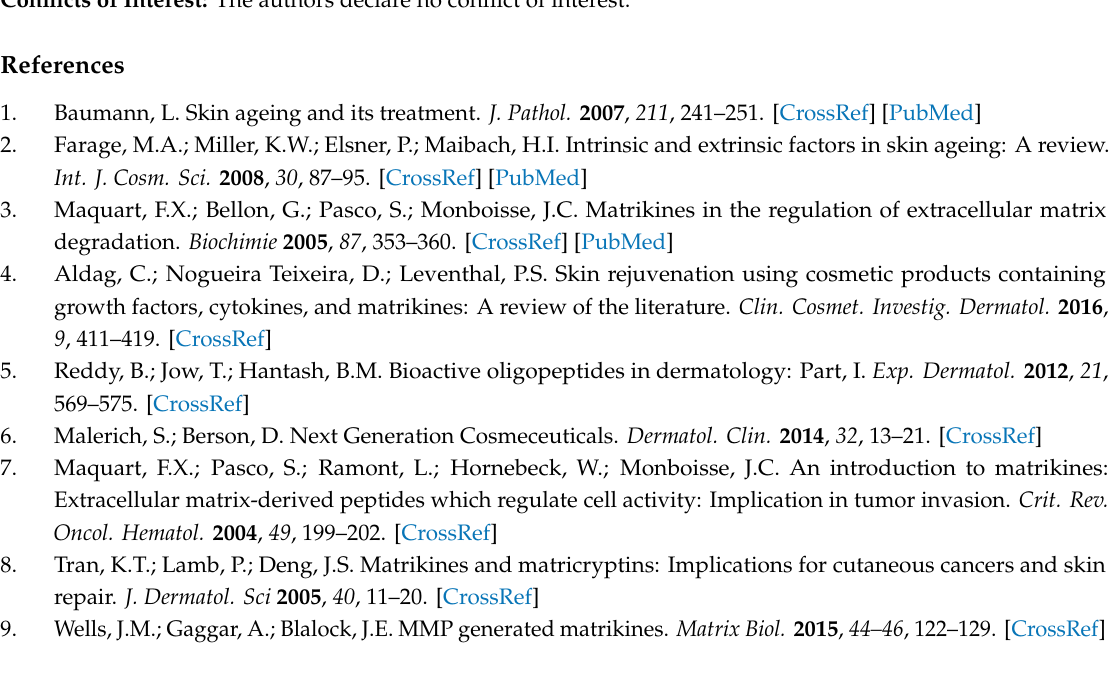
Supplementary Materials: The following are available online, Table S1: Sequences and physico-chemical parameters of synthesized peptides